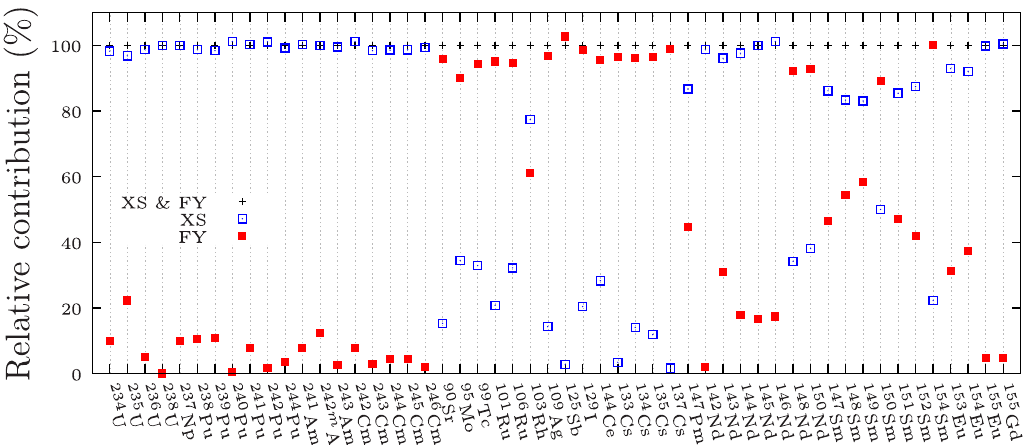
Fig. 5. Relative contributions of the cross sections (called XS) and fission yields (called FY) to the total uncertainties based on the ENDF/B-VIII.0 covariance library.